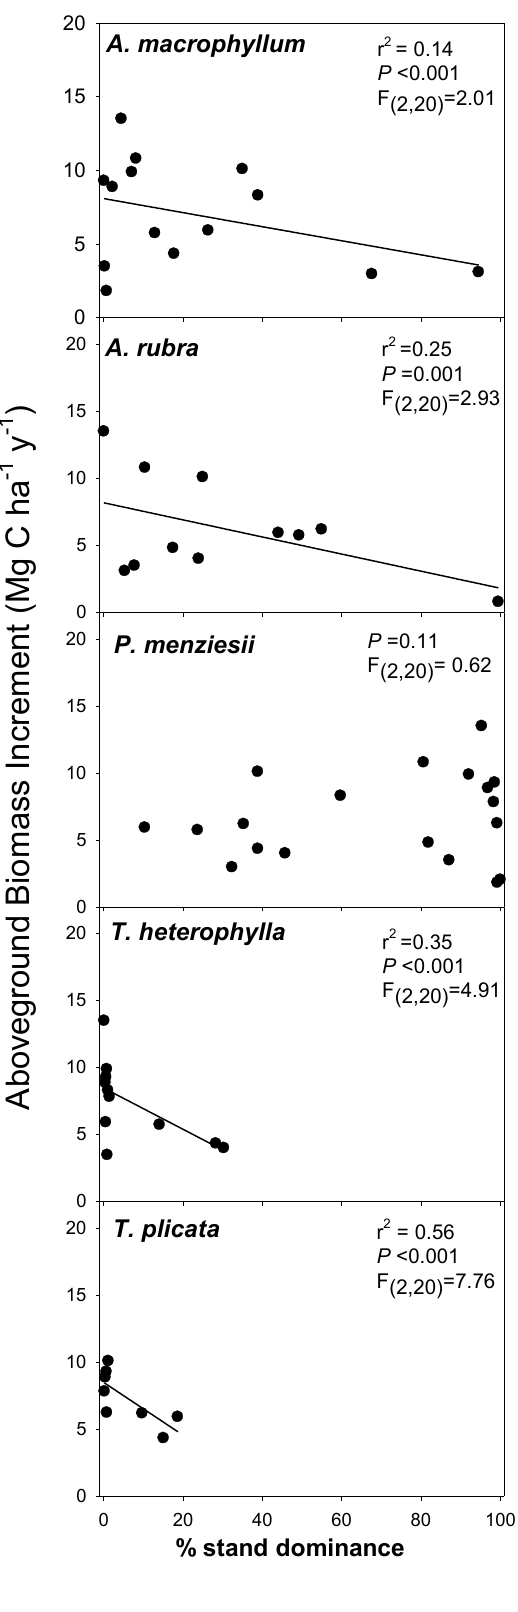
Figure 3. Influence of overstory stand dominance on overstory Aboveground Biomass Increment carbon (ABI). The five most dominant overstory species are represented ( P . menziesii, A. macrophyllum , A. rubra , T. heterophylla, and T. plicata ). Data is only shown for plots where each species is present (zero data